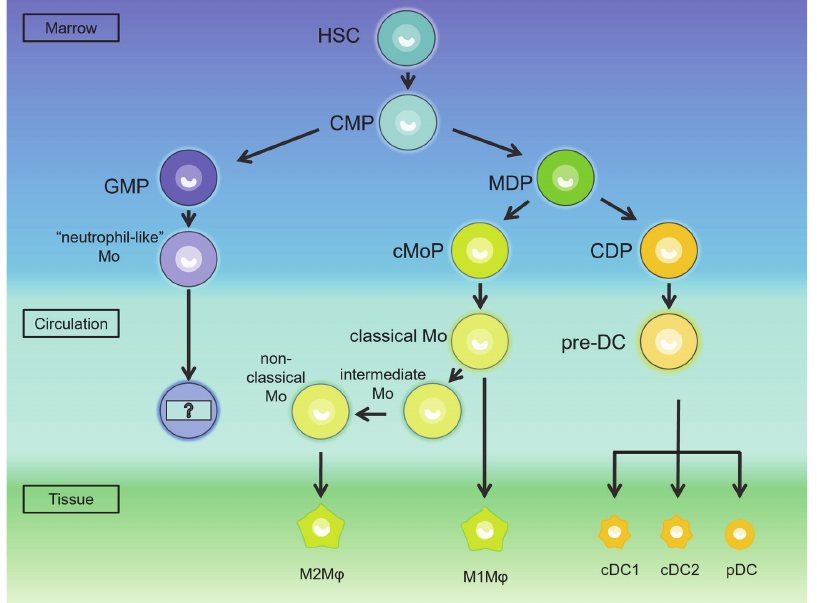
Figure 1. The generation of dendritic cells (DC) and macrophages (M φ ). Hematopoietic stem cell (HSC) first differentiates into myeloid progenitor (CMP). CMP differentiates into monocyte–den ‐ dritic cell progenitor (MDP) and granulocyte–monocyte progenitor cell (GMP). MDP produces two subsets, common monocyte progenitor (cMoP) and common DC progenitors (CDPs). cMoP pro ‐ duces classical monocytes. Classical monocytes can then generate into intermediate and non ‐ classi ‐ cal monocytes. In tissues (epididymis and testes), M1 (classical) macrophages are differentiated from classical monocytes, while M2 (non ‐ classical) macrophages are differentiated from non ‐ classi ‐ cal monocytes. CDP can differentiate into conventional DC1 (cDC1), conventional DC2 (cDC2) and plasmacytoid DC (pDC) through pre ‐ DCs. GMP produces a subset of “neutrophil ‐ like” monocytes. (HSC: hematopoietic stem cell; CMP: myeloid progenitor; MDP: monocyte–dendritic cell progeni ‐